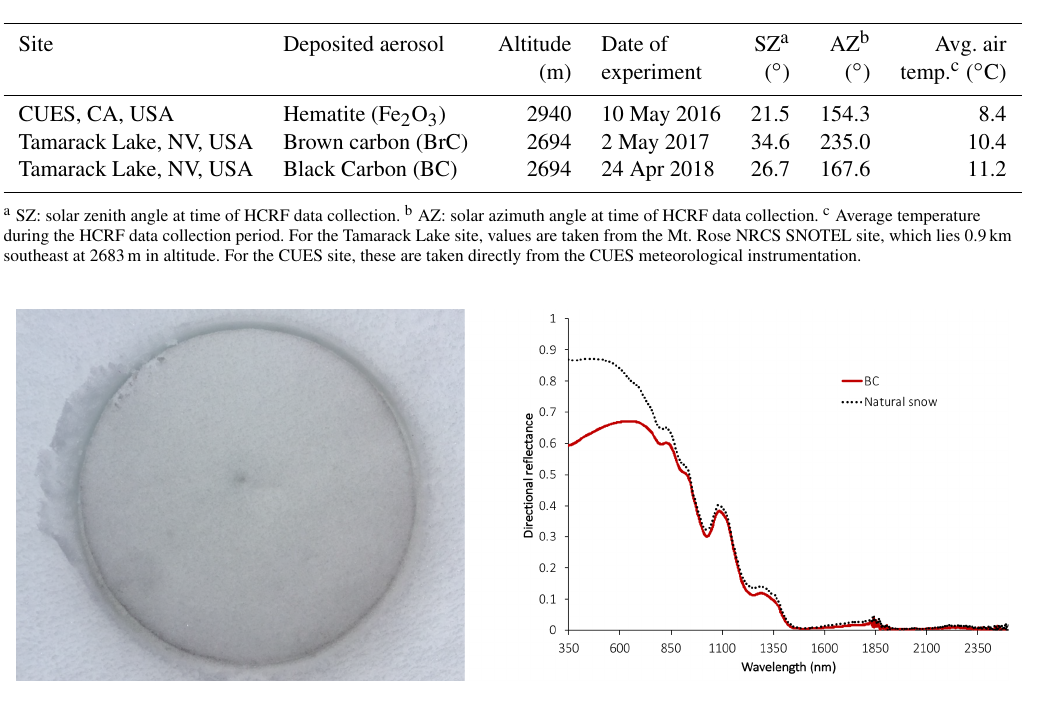
Figure 5. Image and HCRF spectra for a BC deposition and adjacent natural snow in April 2018 at the Tamarack Lake site. This BC deposition drastically reduced the high natural snow reflectivity in the visible and near-visible spectral regions. Solar zenith: 26.7 ◦ ; solar azimuth: 167.6 ◦